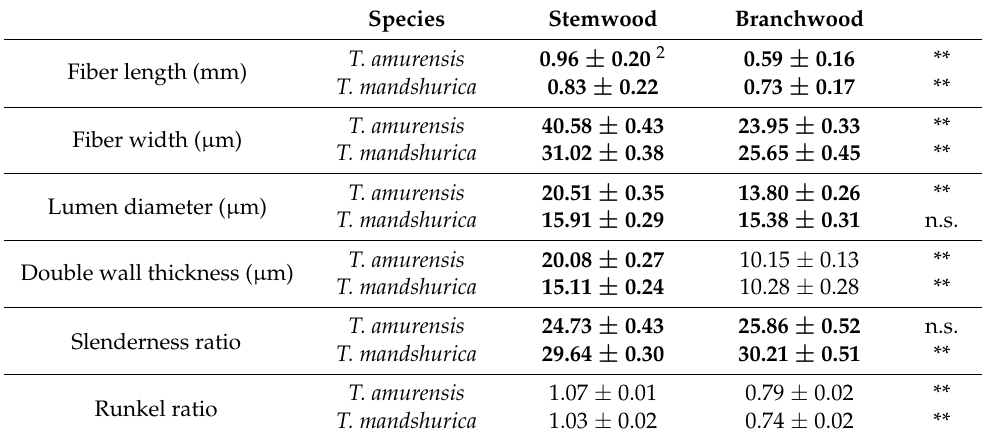
Table 3. Comparison of fiber dimensions and their derived indices of branchwood and stemwood from two Tilia species 1 . Species Stemwood Branchwood Fiber length